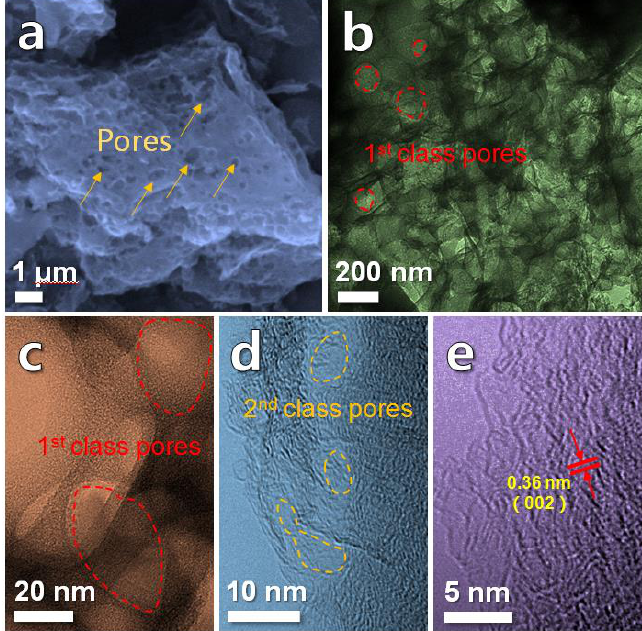
Figure 3. ( a ) Scanning electron microscopy (SEM) image of HPC and ( b – e ) transmission electron microscopy (TEM) images of HPC. Red circles marked in b and c show first class pores. Yellow circles marked in d show second class pores. Arrows in e mark the lattice fringe spacing.